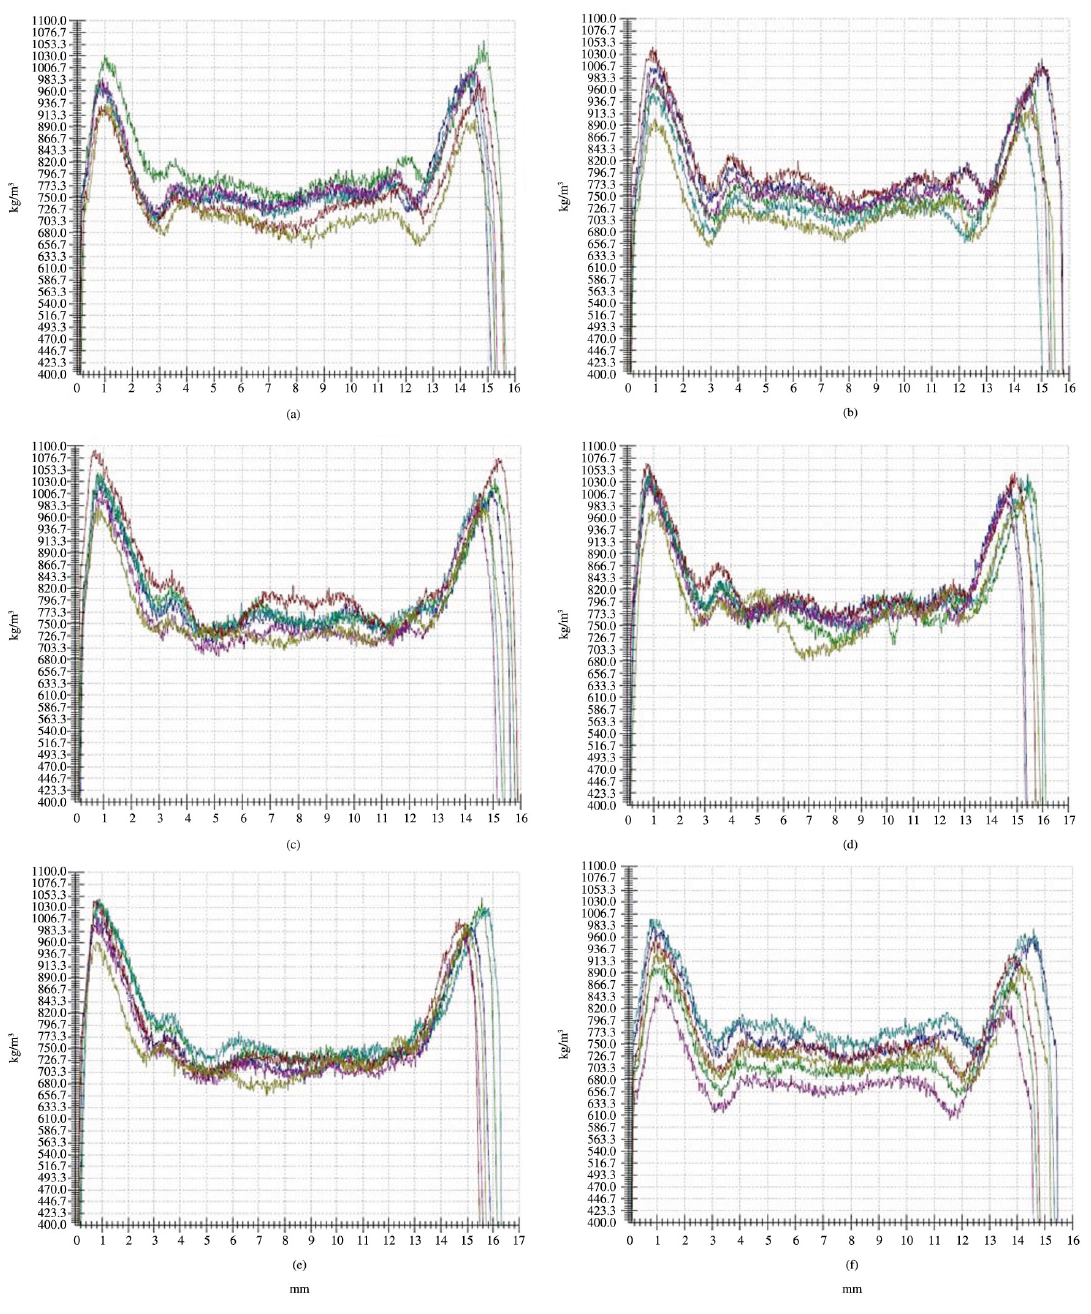
Figure 5. Density profiles, Step B, with 16% resin. (A) 100% eucalyptus, (B) 5% bagasse and 95% eucalyptus (C) 10% bagasse and 90% eucalyptus, (D) 15% bagasse and 85% eucalyptus; (E) 20% bagasse and 80% eucalyptus, (F) 25% bagasse and 75%